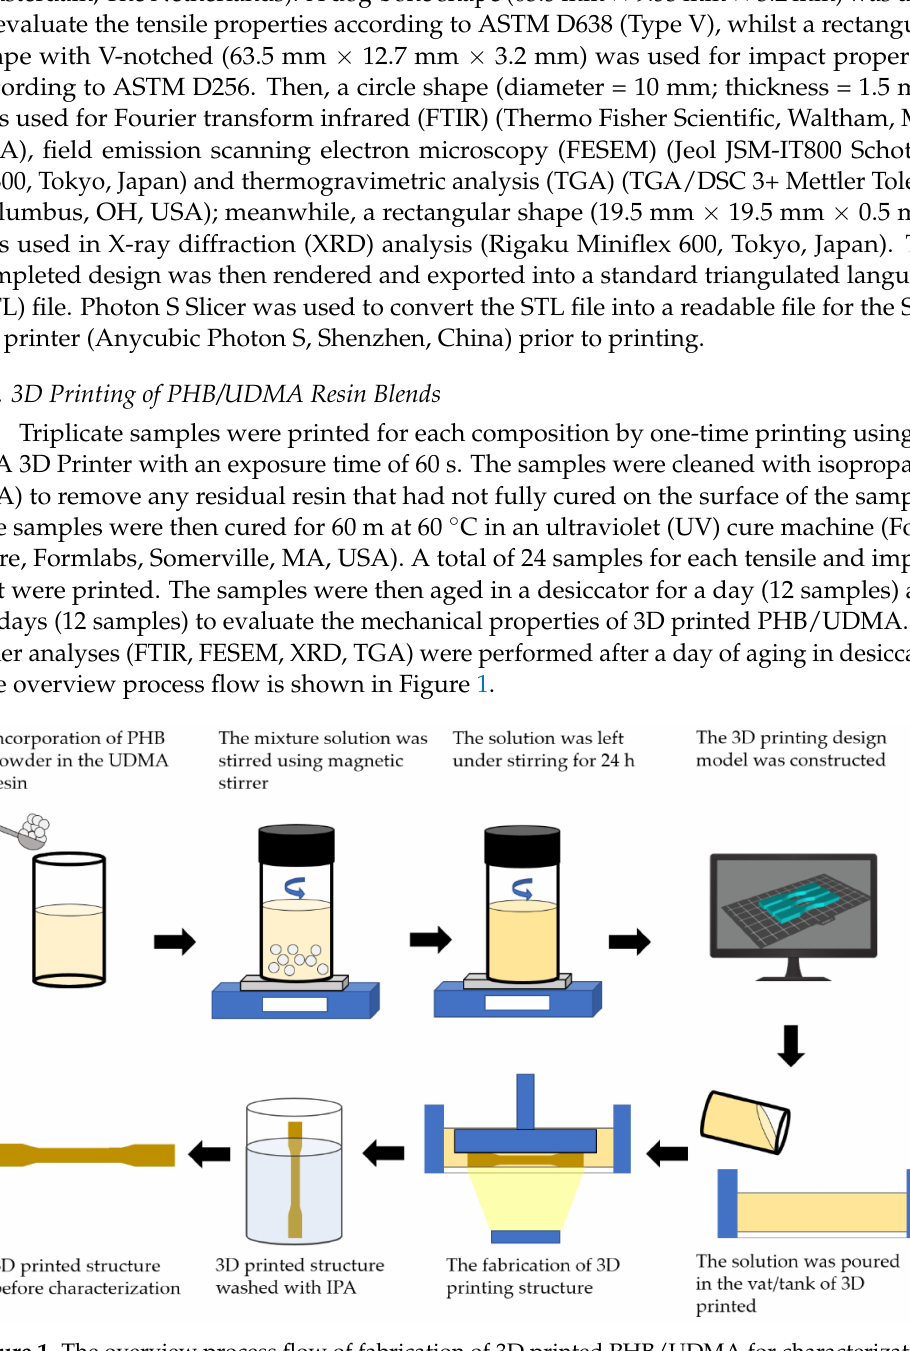
Figure 1. The overview process flow of fabrication of 3D printed PHB/UDMA for